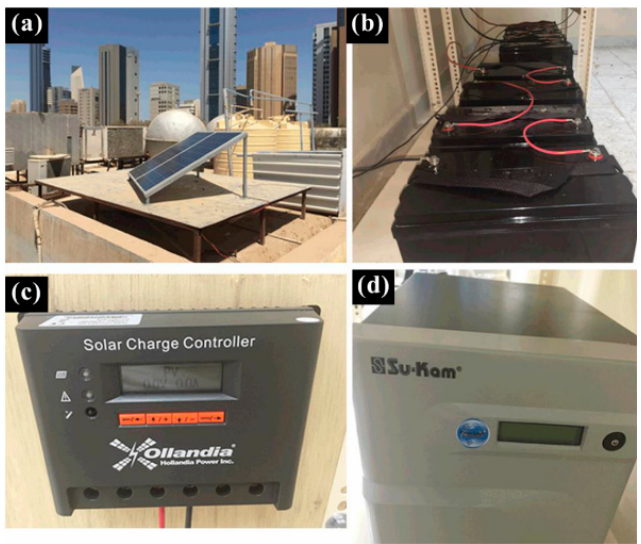
Figure 5. Solar power system set-up for the biodiesel production; ( a ) solar panel over roof surface; ( b ) solar power system 24-volt batteries; ( c ) solar charge controller; ( d ) solar AC/DC converter.